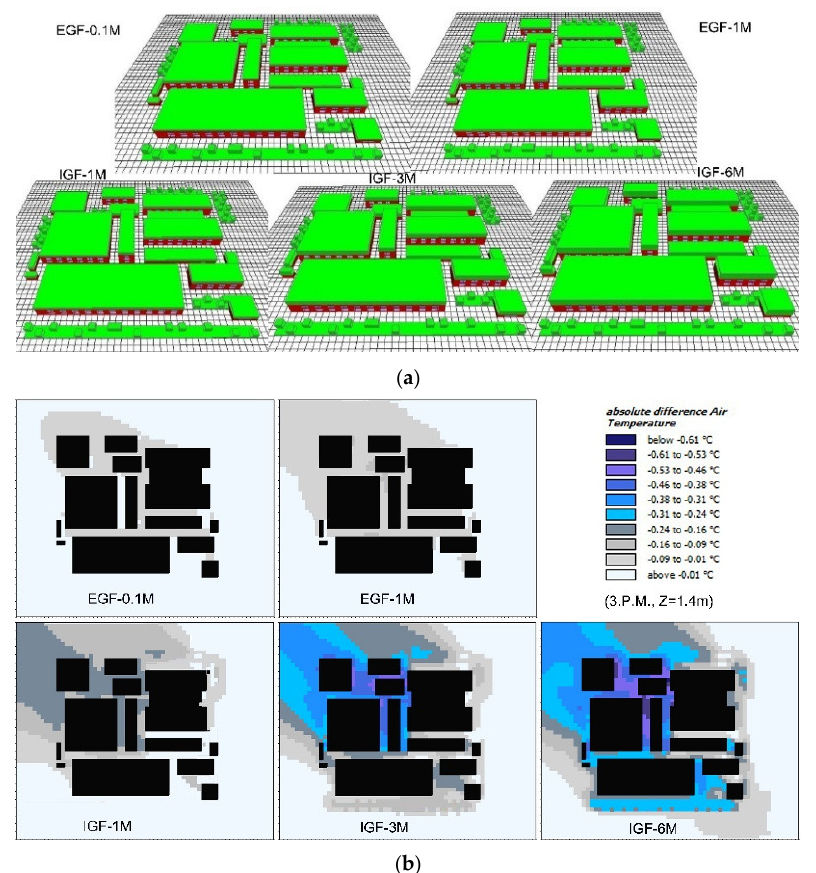
Figure 13. Comparison of the impact of vertical greening height on green roof cooling performance ( a ) Physical models, and ( b ) pedestrian air temperature reduction at 15:00 h.